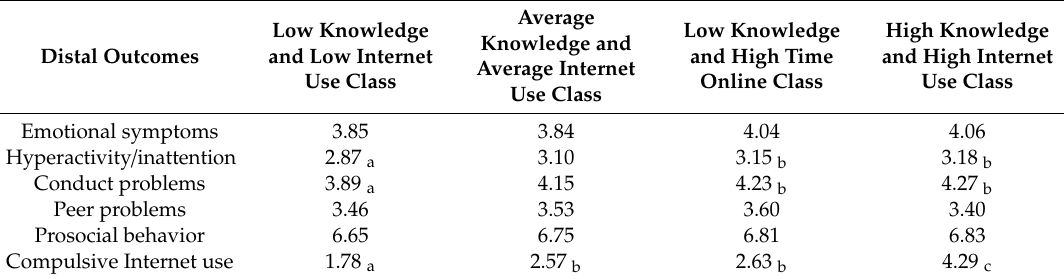
Table 7. Estimates of the various problems by class in the mixture models with emotional and behavioral problems and compulsive Internet use as distal